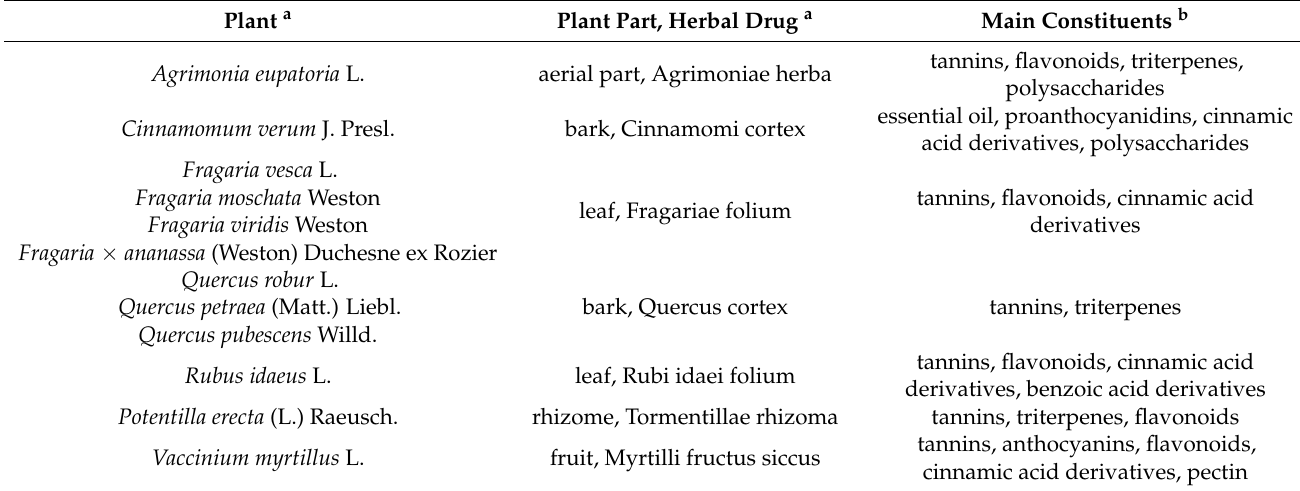
Table 4. Herbal drugs used for functional diarrhoea